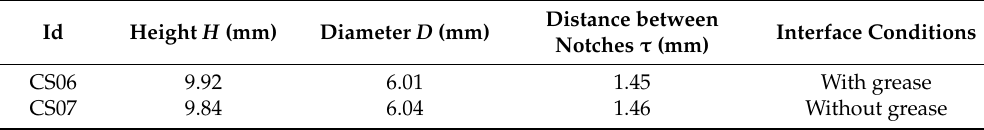
Table 3. Sample dimensions and interface conditions.